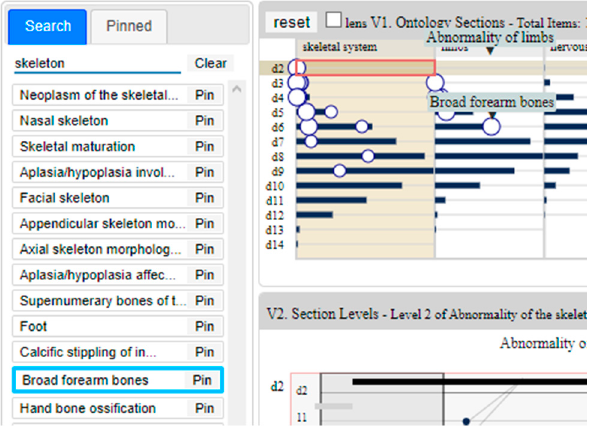
Figure 33. The Ontology Landmark Search results from typing “skeleton”.